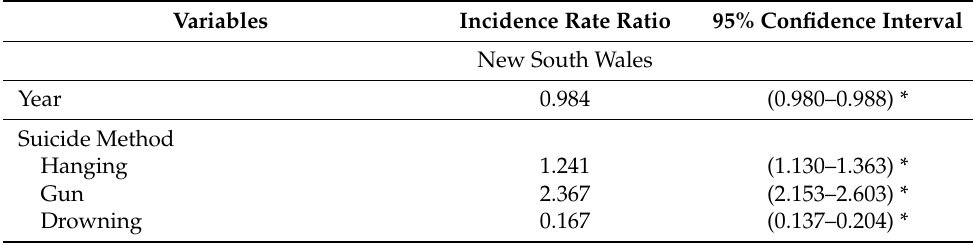
Table 1. Poisson regression analysis of suicide mortality in New South Wales, Victoria, and Western Australia. Variables